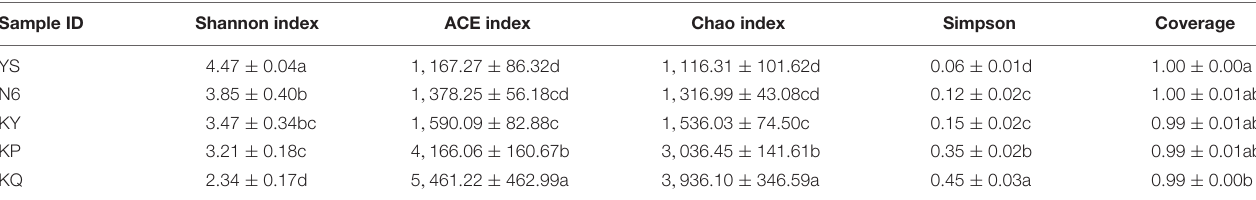
FIGURE 4 | Effects of strain HN6 on the nutrient, FOC4, and fusaric acid contents of rhizosphere soil. N6 ( Foc · TR4-GFP + HN6, 1.0 × 10 7 cfu g − 1 soil), KY ( Foc · TR4-GFP + 0.1% carbendazim), KP ( Foc · TR4-GFP + Gause No. 1 liquid medium), and KQ ( Foc TR4-GFP + sterile water). YS referred to rhizosphere soil of uninoculated plants. (A) Total nitrogen and organic matter content of rhizosphere soil sample. (B) Available phosphorus and available potassium content of rhizosphere soil sample. (C) FOC4 and FA content of rhizosphere soil sample. Error bars represent standard deviations, and means with different letters are significantly different from each other ( p < 0.05) according to the LSD test ( n = 3). TABLE 6 | Statistical table of alpha diversity